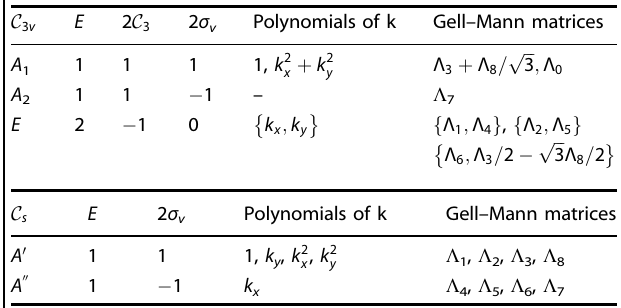
Table 1. Character tables a for the point groups C 3 v and C s